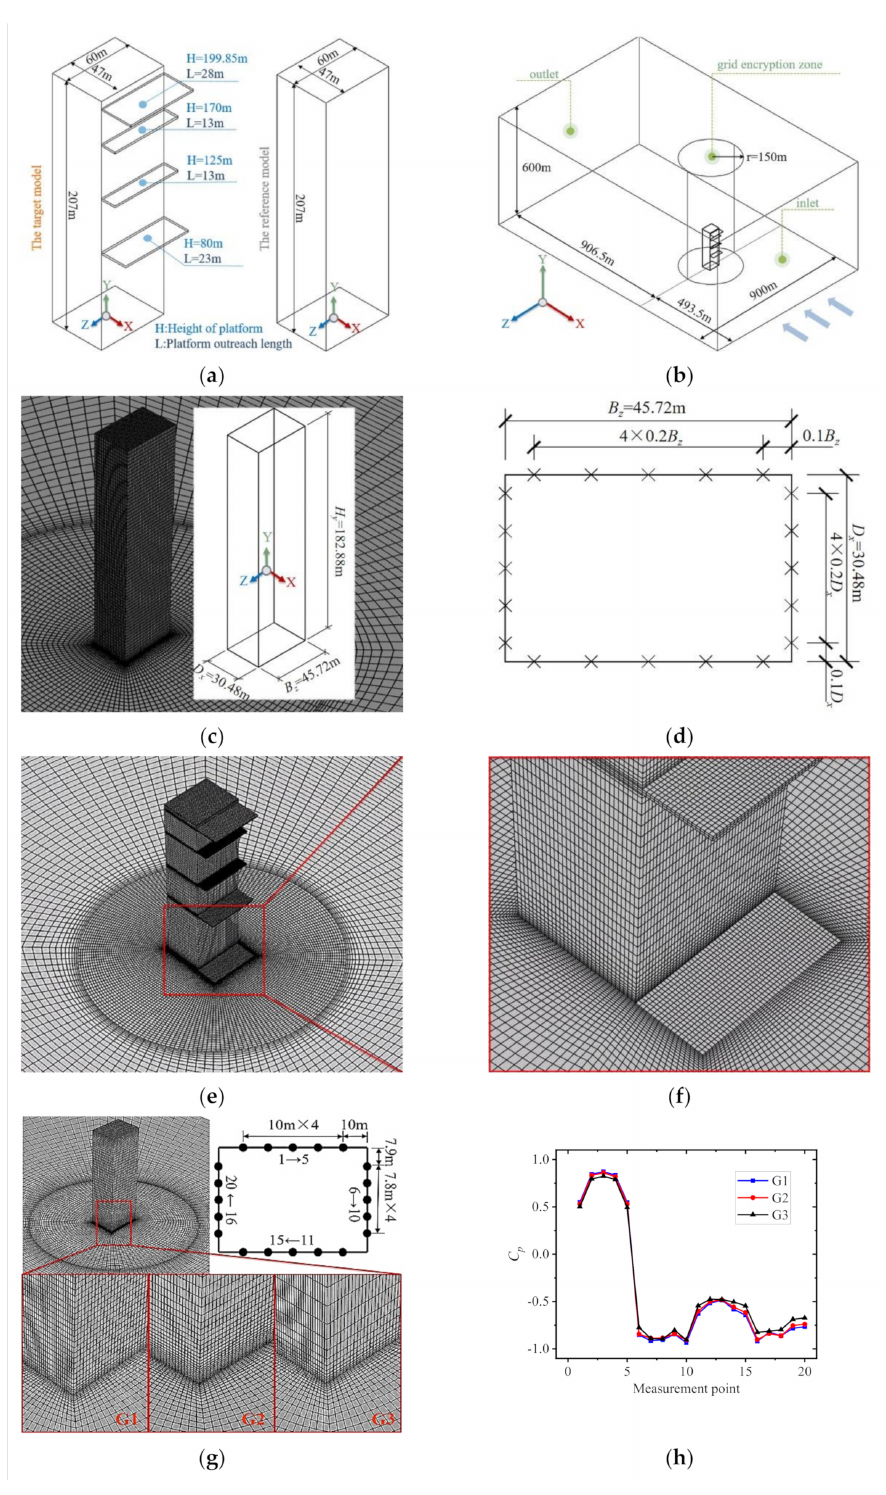
Figure 1. Modelling and meshing. ( a ) The Tar Model and the Ref Model; ( b ) Computational domain conditions; ( c ) CAARC Model; ( d ) CAARC model measurement point setup; ( e ) Overall model meshing; ( f ) Details of near-ground meshing; ( g ) Mesh division method and measurement point arrangement for grid-independent verification; ( h ) Mean wind pressure coefficients at measurement points for grid-independence